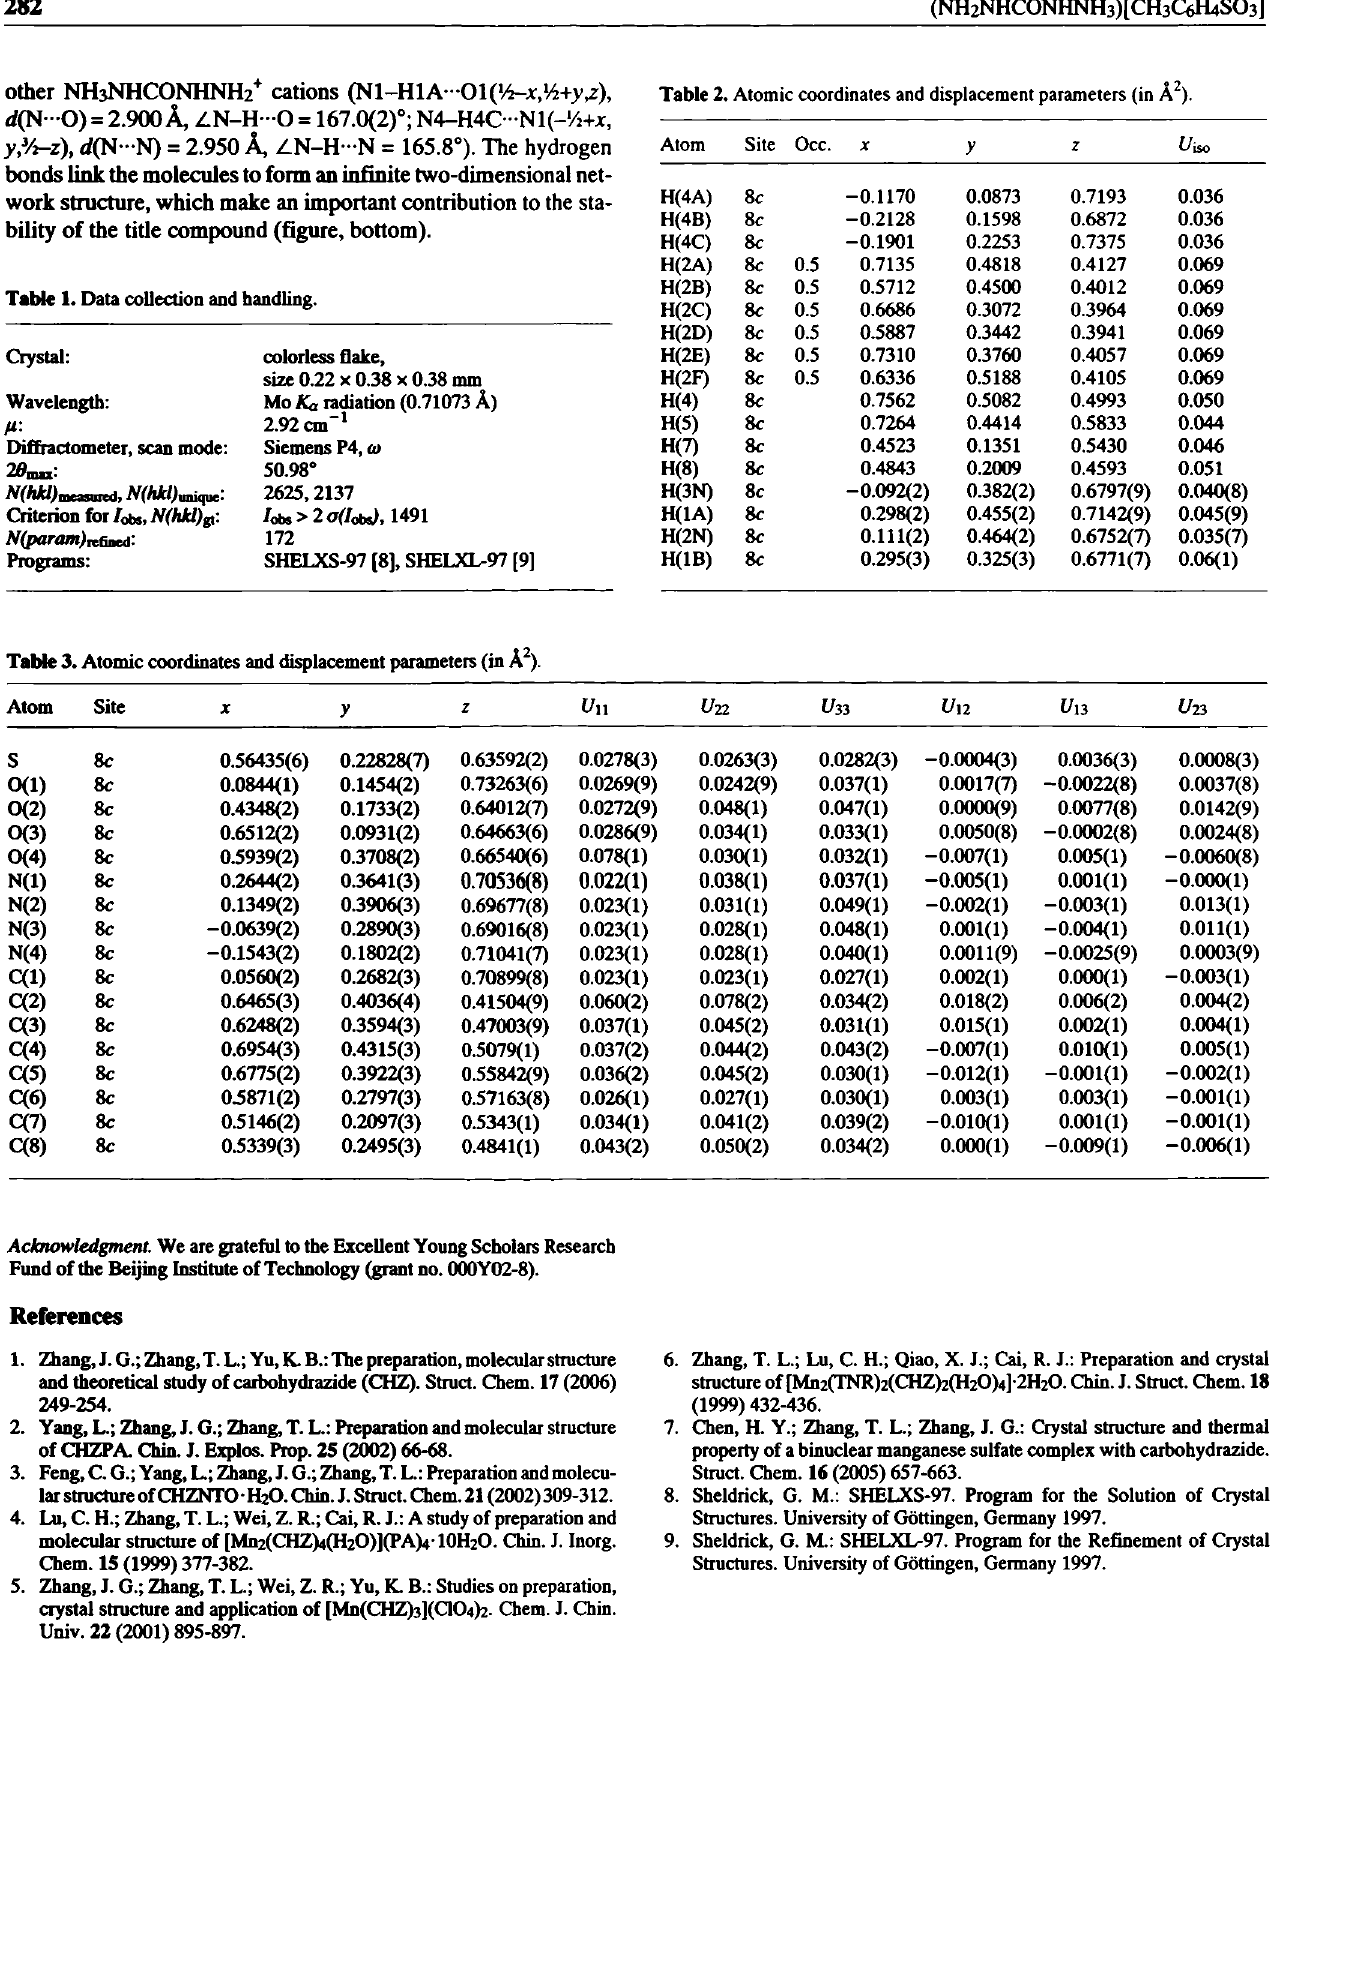
Table 2. Atomic coordinates and displacement parameters (in A ).